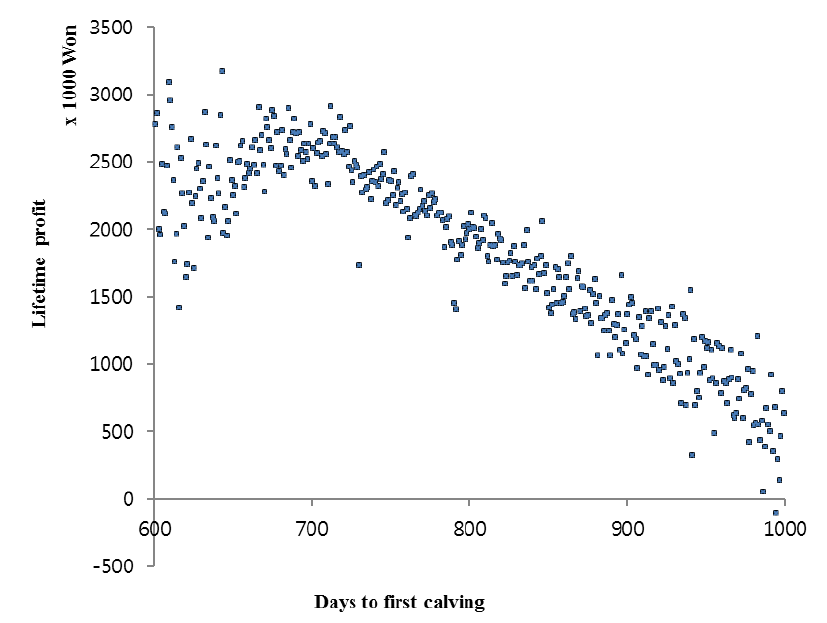
Figure 3. Distribution of lifetime profit according days to first